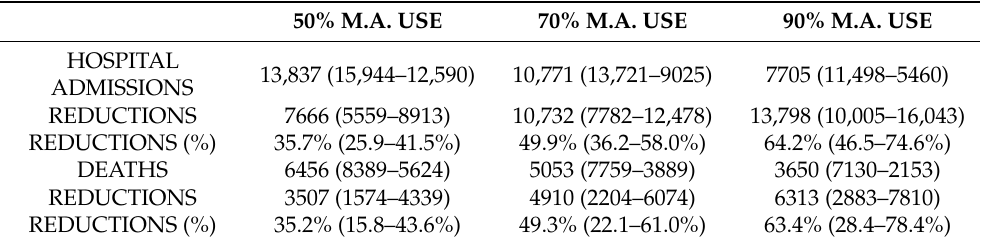
Table 2. Projected hospital admissions and deaths in subjects above 70 years of age who received monoclonal antibodies. 50% M.A. USE 70% M.A. USE 90% M.A. USE